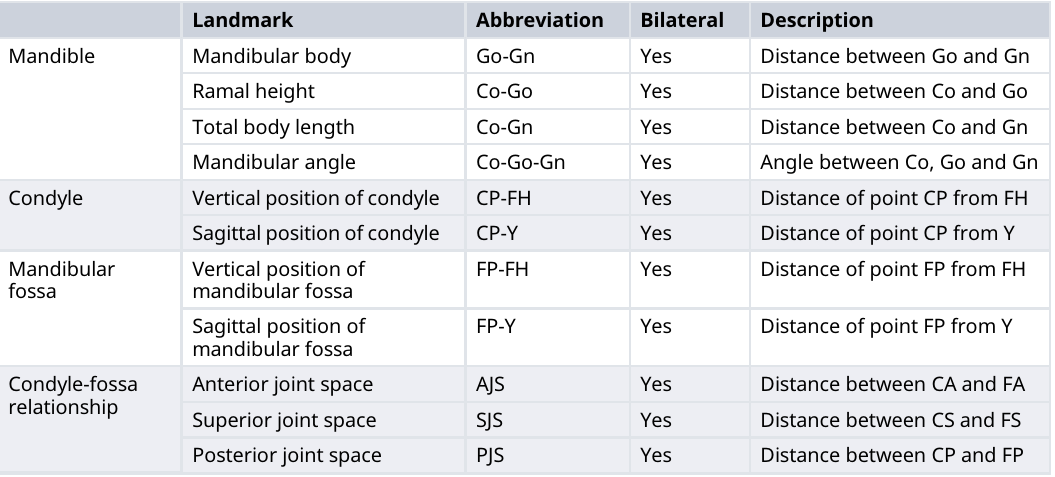
Table 2. Definitions of the linear and angular